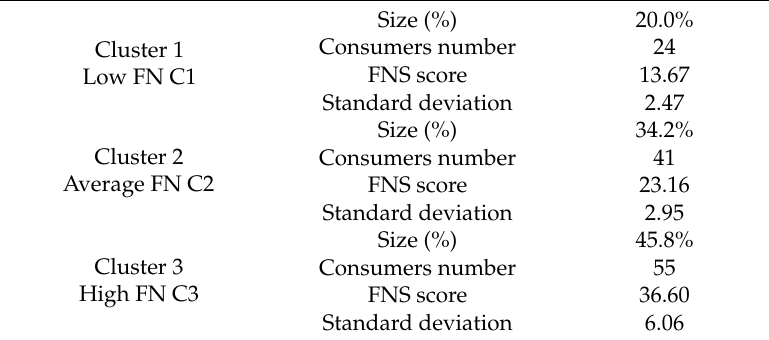
Table 6. Results of the two-steps cluster analyses using the adapted